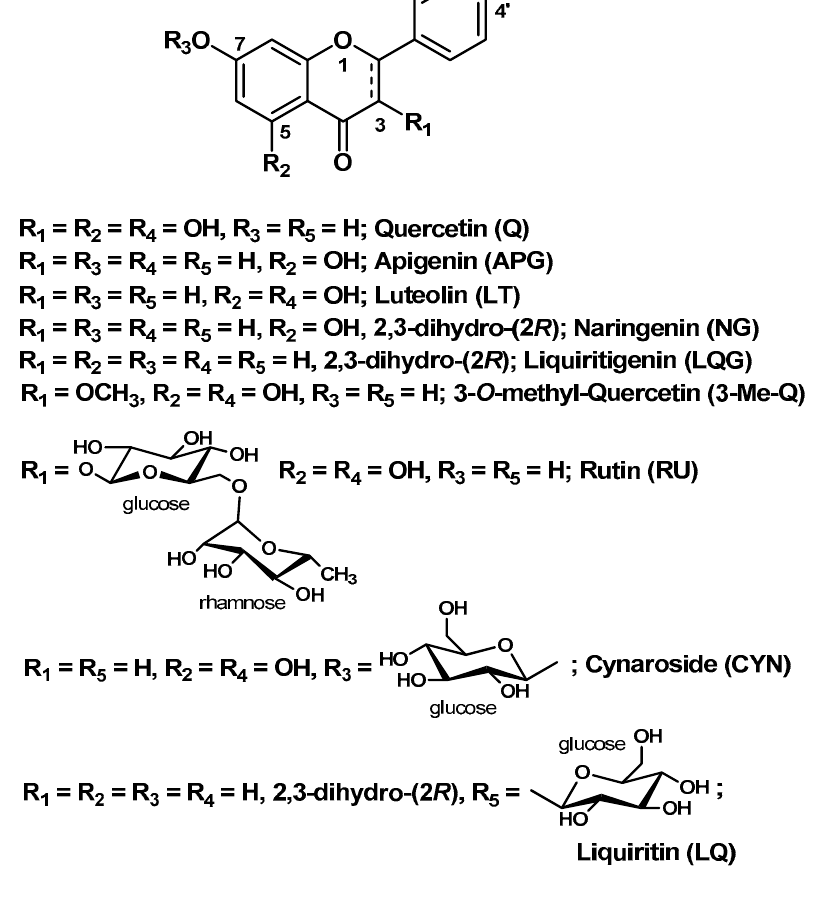
Figure 3. Chemical structure of quercetin (Q) and some related natural occurring flavonoids. The properties of Q, together with the capability of the HGs to load / deliver hydrophobic wound dressings for the healing of wounds, especially those associated with chronic